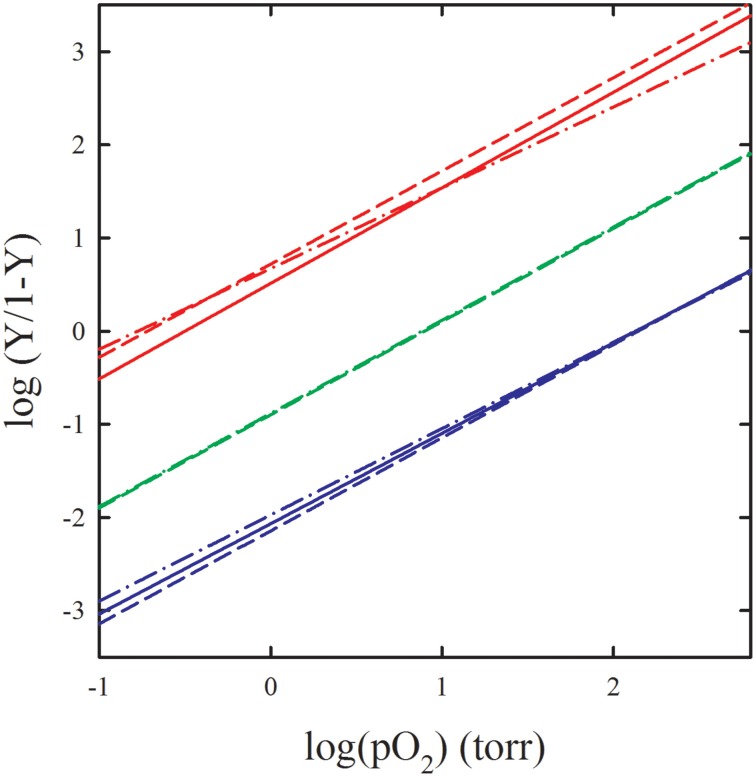
Comparison of oxygen binding curves of HbA in the crystal, in gel and in solution. Oxygen binding to: R state Hb C crystals (red continuous line) (Shibayama et al., 2011), R state Hb gels (red dot-dash line) (Shibayama and Saigo, 1995), R state Hb in solution (red dash-dash line) (Yonetani et al., 2002), T state Hb crystals (blue continuous line) (Mozzarelli et al., 1997), T state gels in the presence of allosteric effectors (blue dot-dash line) (Viappiani et al., 2004), Hb in solution in the presence of allosteric effectors (blue dash-dash line) (Yonetani et al., 2002), T state Hb gels in the absence of allosteric effectors (green dot-dash line) (Bruno et al., 2001a), T state Hb in solution in the absence of allosteric effectors (green dash-dash line) (Poyart et al., 1978).